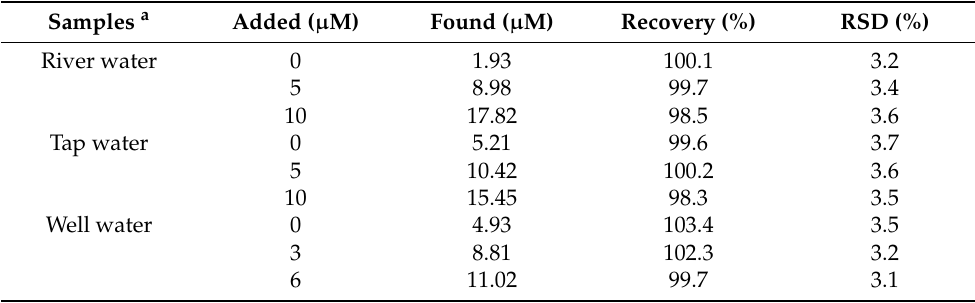
Table 1. Analytical results of Fe 3+ in real samples using MLR as a probe. Samples